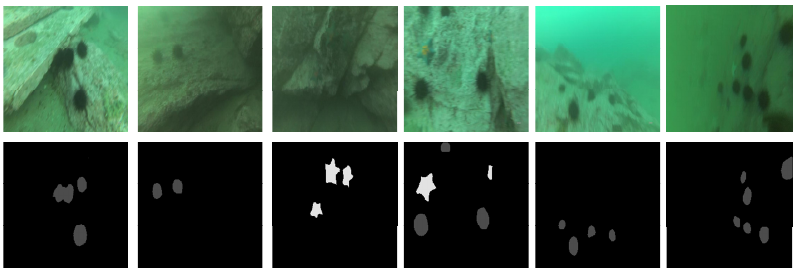
Figure 3. E xamples of different levels of blur obtained by the proposed MulTNet. Figure 3. Examples of different levels of blur obtained by the proposed